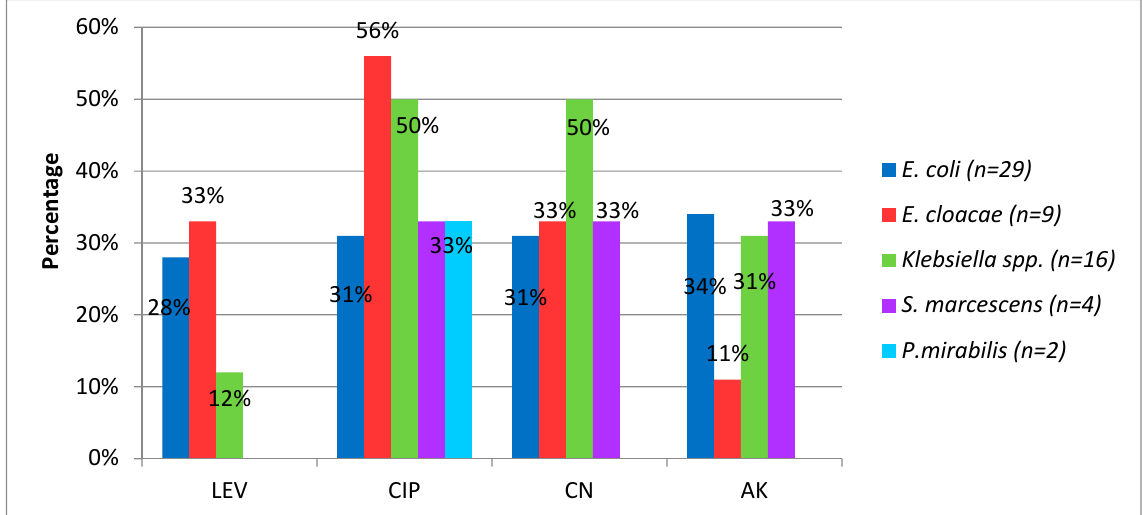
Figure 5. Percentage of resistance to non-beta-lactam antibiotics in Gram-negatives bacilli causing neonatal infection. LEV, levofloxacin CIP, ciprofloxacin GM, gentamicin AK, amikacin.